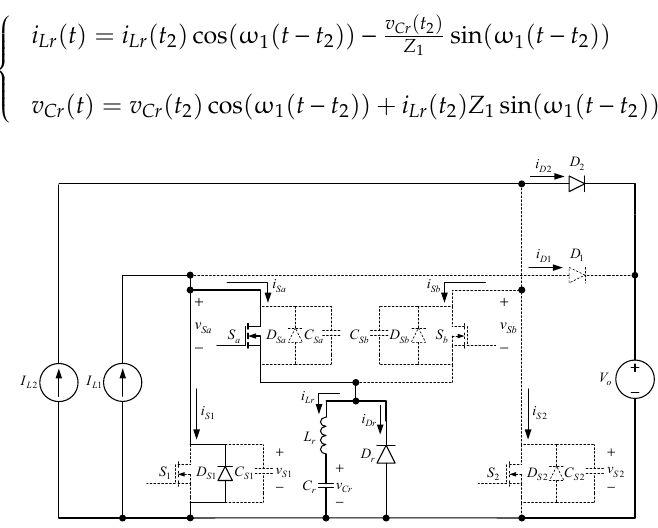
Figure 6. Current path in mode 3.